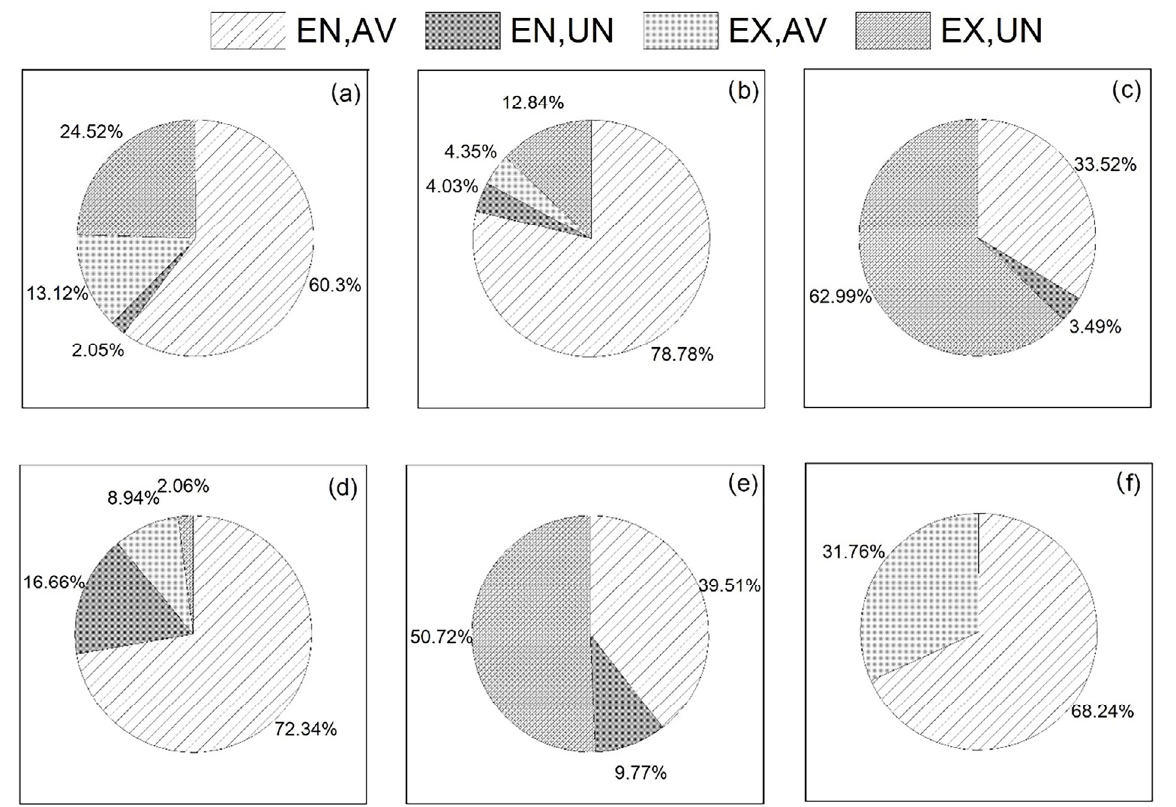
Figure 8. Exergy disaggregation destroyed ( a ) turbine, ( b ) pump-1, ( c ) pump-2, ( d ) ITC 1, ( e ) evaporator, and ( f ) condenser. Table 11. Disaggregation of exergy destroyed for each